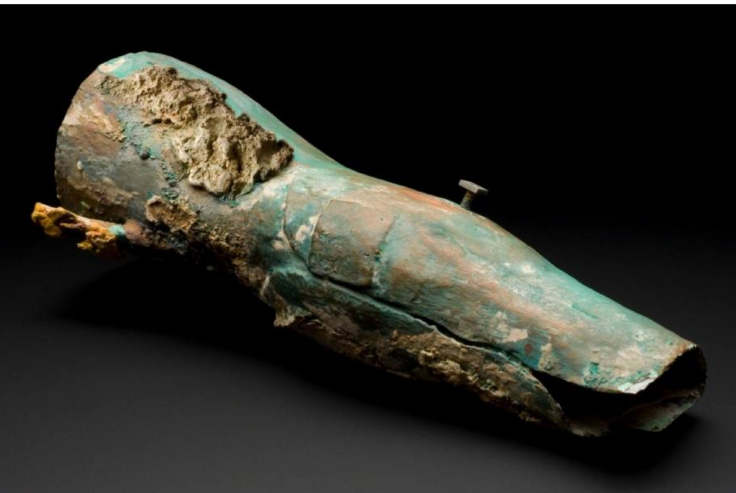
Figure 1. Copy of Roman artificial leg, London, England, c. 1910. Science Museum, London. https: //wellcomecollection.org/works/kyjgqfuh (accessed on 15 July 2021). Attribution 4.0 International (CC BY